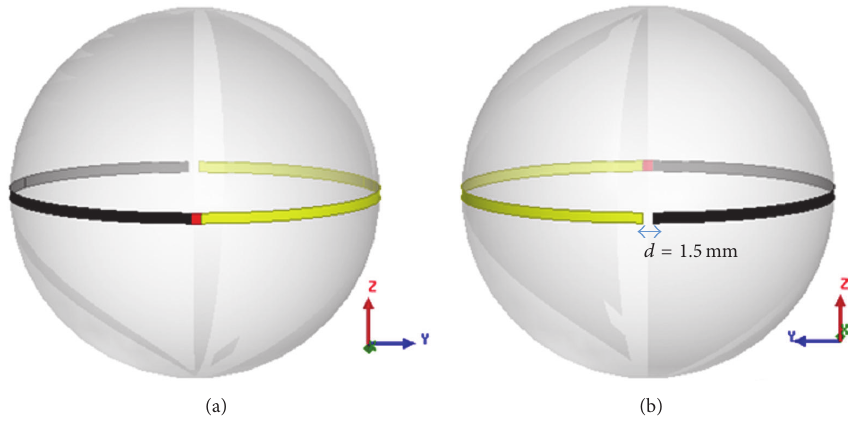
Figure 2: Structure of the spherical 3D antenna ( 𝑟 = 26.34 mm): (a) front view and (b) back view.